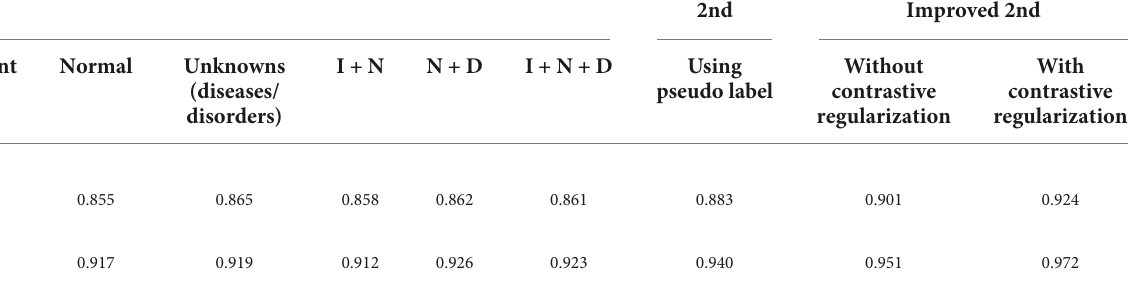
TABLE 3 Performance of the two-head network with different experimental settings.